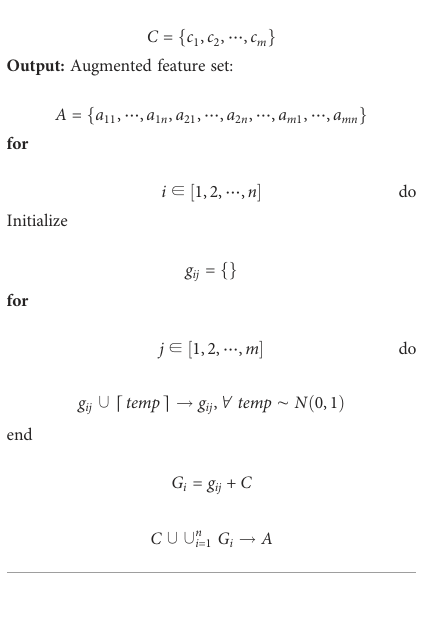
Algorithm 2: Algorithm 1: Data Augmentation Method 2 Input: Cluster feature set: